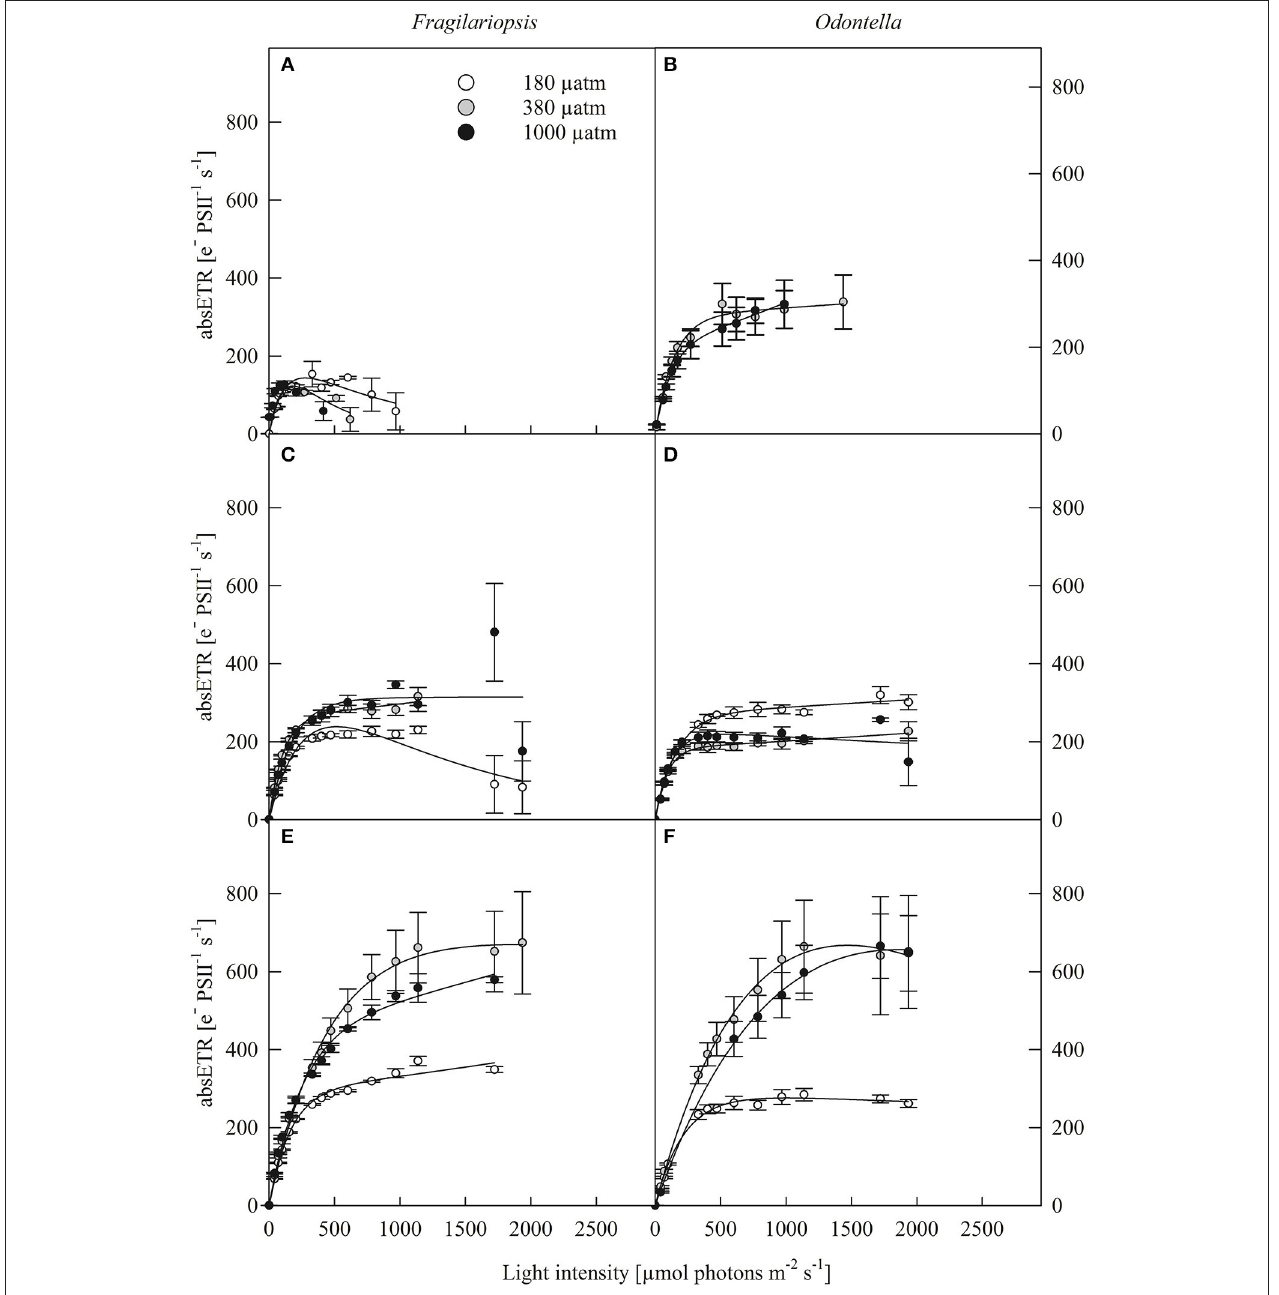
FIGURE 2 | Absolute electron transport rates (absETR, e − PSII − 1 s − 1 ) of Fragilariopsis and Odontella acclimated to different light (LL = 20 in A,B ; ML = 200 in C,D ; HL = 500 µ mol photons m − 2 s − 1 in E,F ) and pCO 2 (low = 180, ambient = 380 and high = 1000 µ atm) conditions. Values represent mean ± SE ( n = 3). Lines represent the fit following Ralph and Gademann